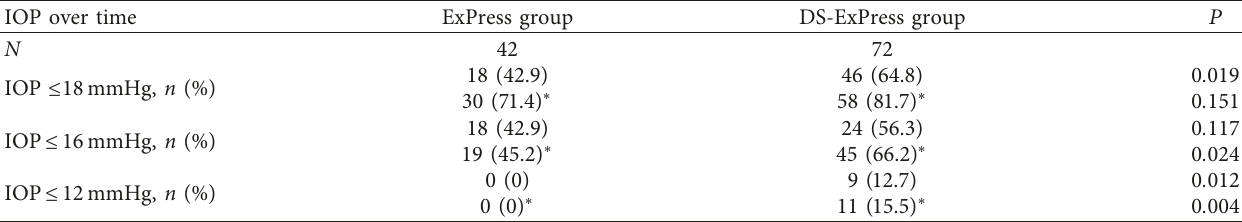
Table 3: Intraocular pressure (IOP) in the ExPress and DS-ExPress groups at the end of the observation period. IOP over time ExPress group